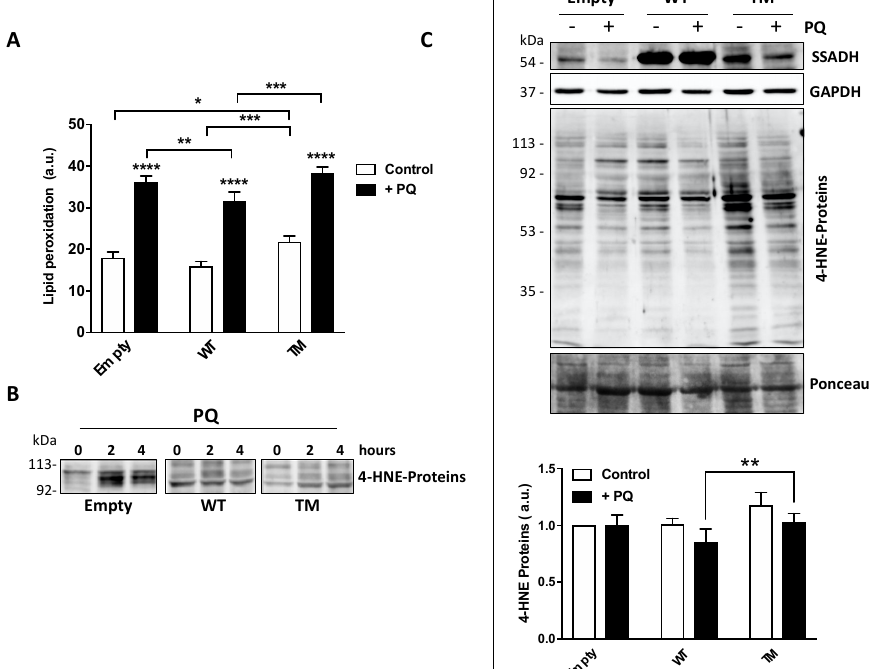
Figure 4. Markers of oxidative stress are increased in U87 cells transfected with the triple mutant succinate semialdehyde dehydrogenase (TM SSADH) upon paraquat (PQ) treatment. ( A ) Cells were transiently transfected for 24 h and then treated with 1 mM PQ. Lipid peroxidation was measured by C11 BODIPY using a flow cytometer. Ten thousand cells were analyzed for each sample and fluorescent intensities expressed as arbitrary units (counts within FL1-H fluorescence). Data are presented as mean ± SD. n = 3, * p < 0.05, ** p < 0.01, *** p < 0.001, **** p < 0.0001; ( B ) representative Western blot analysis of 4-HNE-modified protein levels in transfected cells treated with 1 mM PQ for 2 or 4 h. Immunoreactive bands with molecular weight around 100 kDa are shown. A total of 20 µg of total protein extract was loaded on each lane; ( C ) Western blot analysis of 4-HNE-modified protein levels upon 1 mM PQ treatment for 24 h. SSADH levels and glyceraldehyde 3 phosphate dehydrogenase (GAPDH) are also shown; ( D ) the intensity of the bands of the 4-HNE-modified protein levels in panel ( C ) was calculated with reference to both the untreated empty vector and protein staining with Ponceau. Data are expressed as mean ± SD, n = 4, ** p < 0.01.